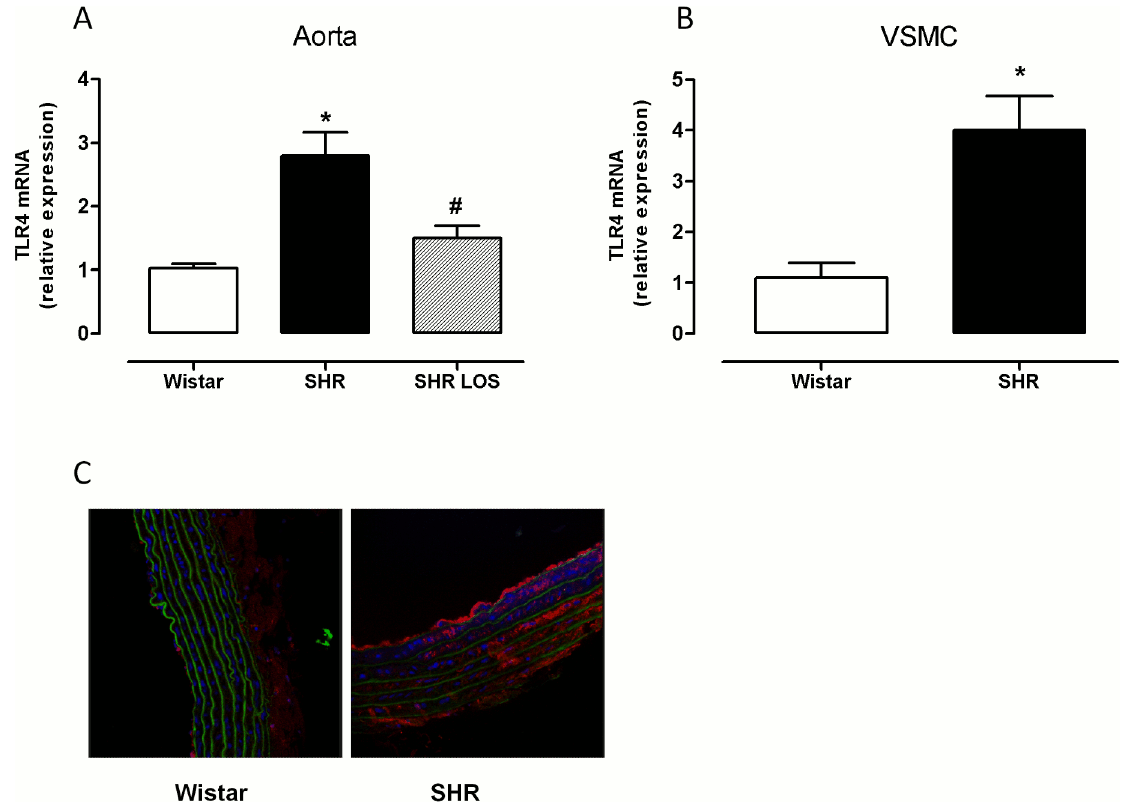
Figure 1. Ang II contributes to the increased TLR4 mRNA levels observed in SHRs. (A) TLR4 mRNA levels in aortic segments from Wistar, SHRs and SHRs treated with losartan (15 mg/kg ? day in the drinking water, 12 weeks). (B) TLR4 mRNA levels in VSMCs from Wistar rats and SHRs. (C) Representative fluorescent confocal photomicrographs of TLR4 immunolocalization in aortic segments from Wistar and SHRs. Image size 238 6 238 m m. The results (mean 6 SEM) are expressed as the relative expression compared with the Wistar rats. *P , 0.05 vs. Wistar, # P , 0.05 vs . SHR using the Mann-Whitney nonparametric test. n=6–7.